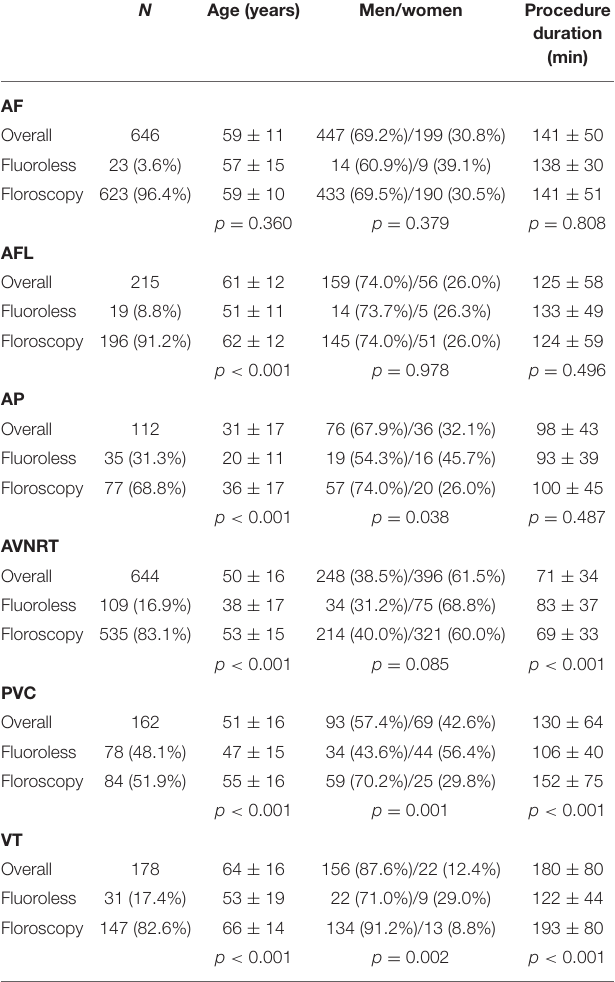
TABLE 2 | Patients’ characteristics by arrhythmias treated.